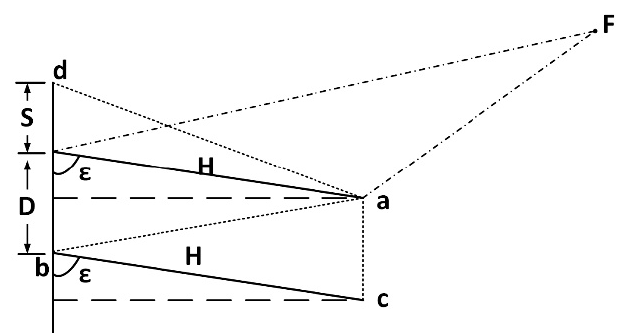
Figure 10. Overhang collectors, 𝐻 .